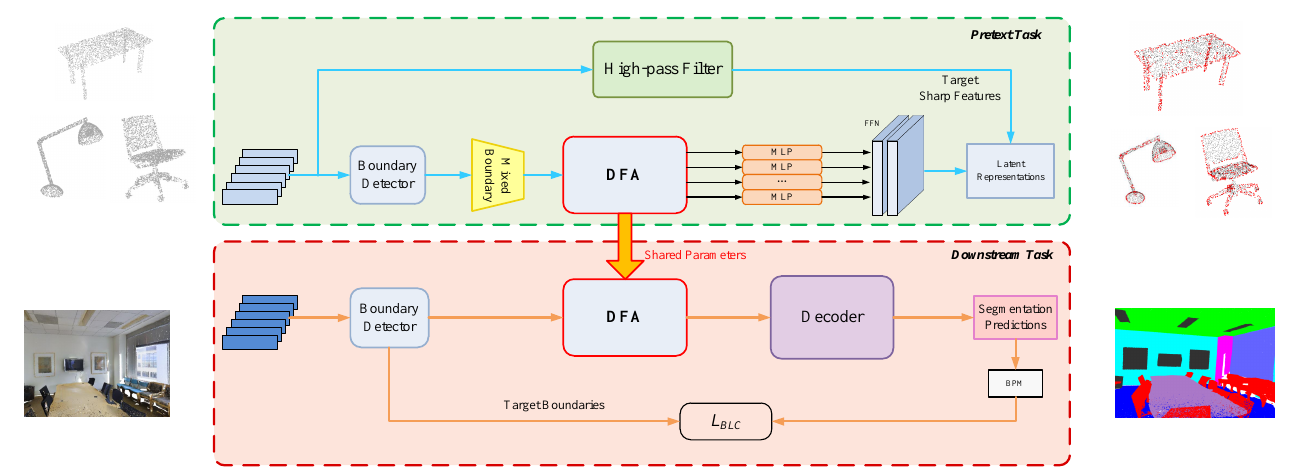
Figure 2. An overview of the proposed boundary-aware architecture for point cloud semantic seg- mentation. We first carry out a mixed feature prediction (MFP) task on ShapeNet to learn prior knowledge. Then, we fine-tune the network on downstream tasks based on the shared parame- ters. The boundary detector serves as an auxiliary supervised signal to maintain the correctness of the